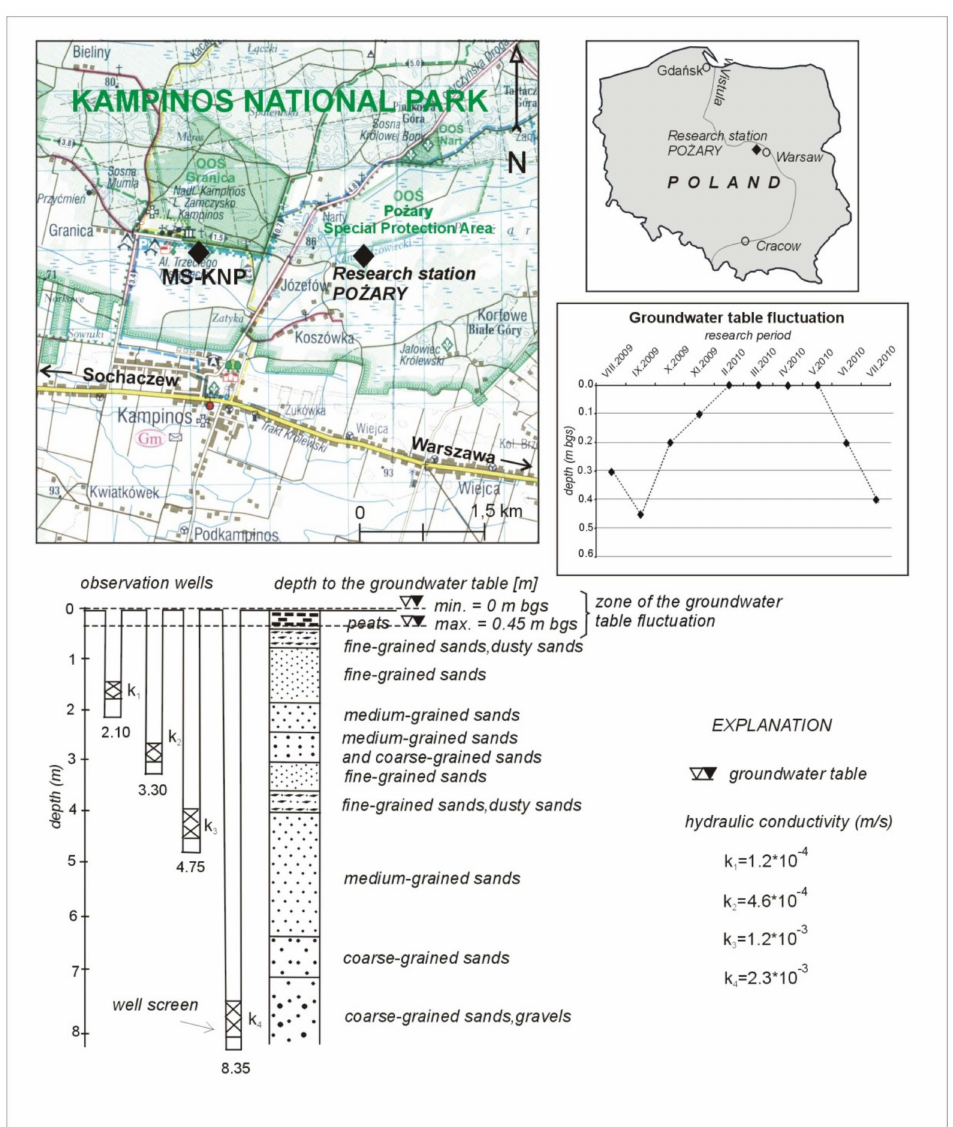
Figure 1. Location of the Po˙zary research station, geologic profile, and arrangement of piezometers for groundwater sampling. MS-KNP—meteorological station of Integrated Monitoring of the Natural Environment of the Kampinos National Park (KNP). Geological profile after Fic and Wierzbicki [17] modified by the